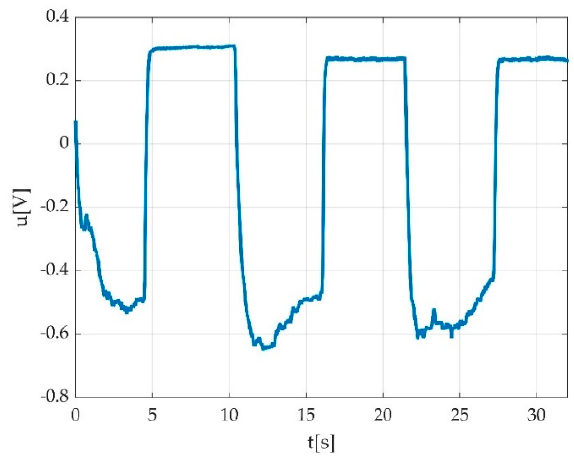
Figure 25. An example of dorsiflexion contraction indexed as a plantar flexion.